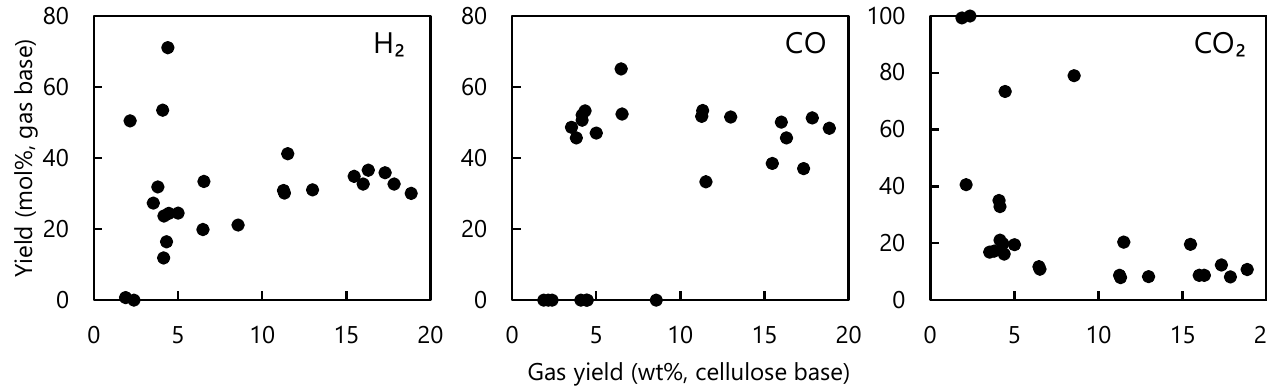
Figure 5. Proportions of H 2 , CO and CO 2 in the gaseous products as functions of the overall gas yield from the fast pyrolysis of Whatman cellulose.